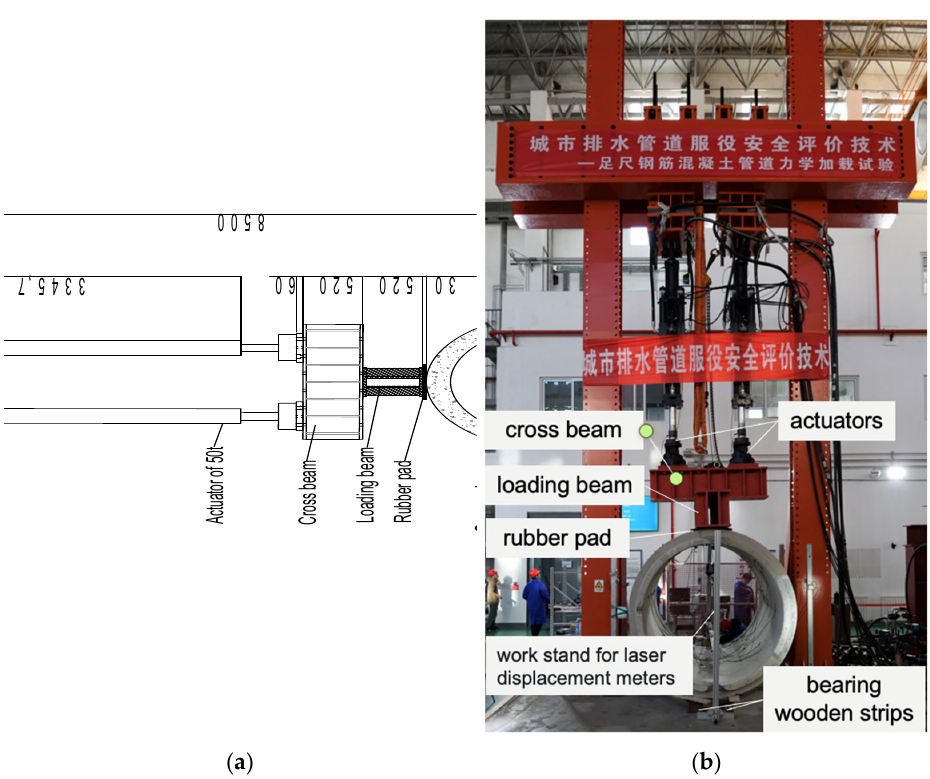
Figure 4. Three ‐ edge bearing test system built in the NCMS. ( a ). Elevation schematic of TEBT; ( b ). Physical test set up of TEBT.